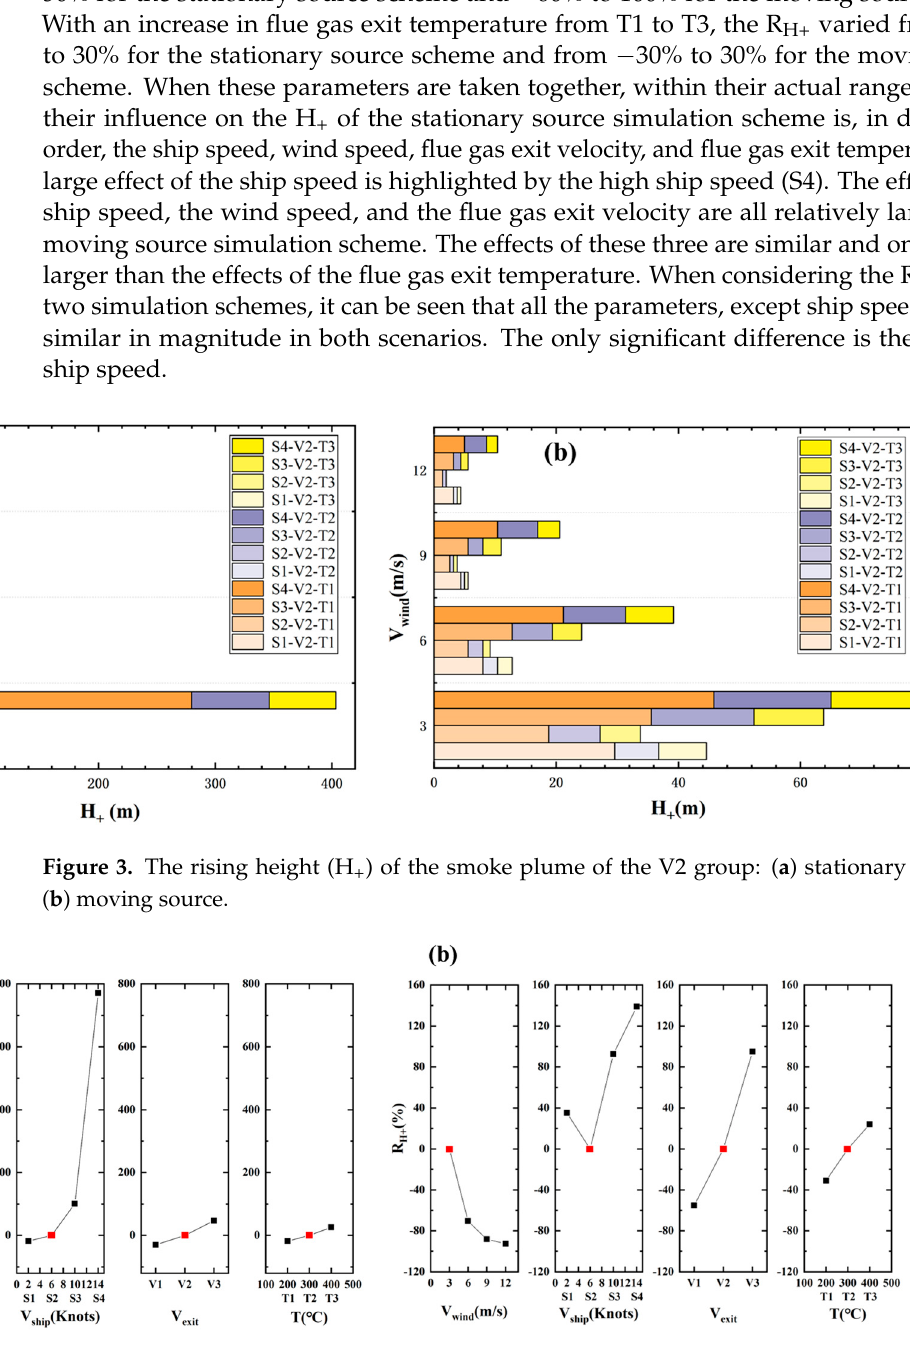
Figure 4. The relative rate of change (R H+ ) in the H + for the simulation schemes with influencing parameters: ( a ) stationary source and ( b ) the moving source (red dots indicate reference scenario: S2 − V2 − T2 scenario at a wind speed of 3 m/s).